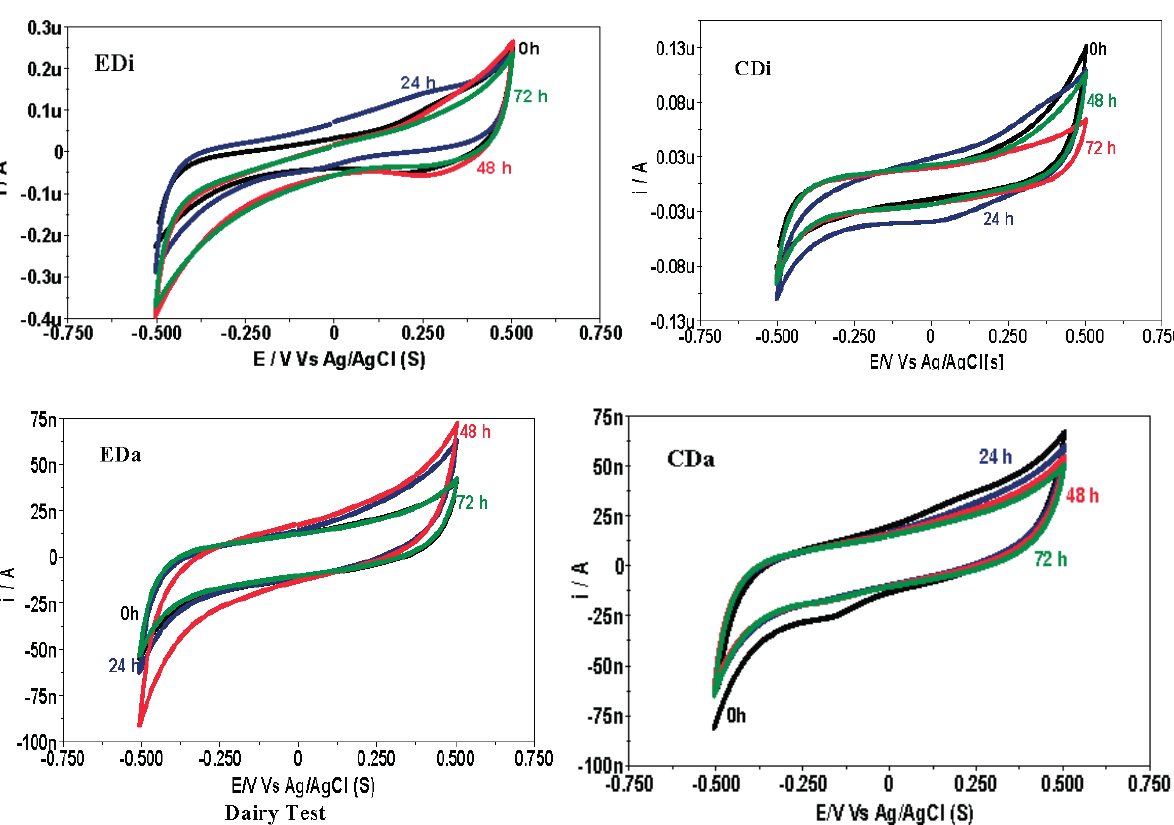
Figure 8. Cyclic voltammograms of dark-fermentative system (DFS- CDi, CDa) and augmented dark-photo fermentative system (ADPFS- EDi, EDa) operated with distillery and dairy